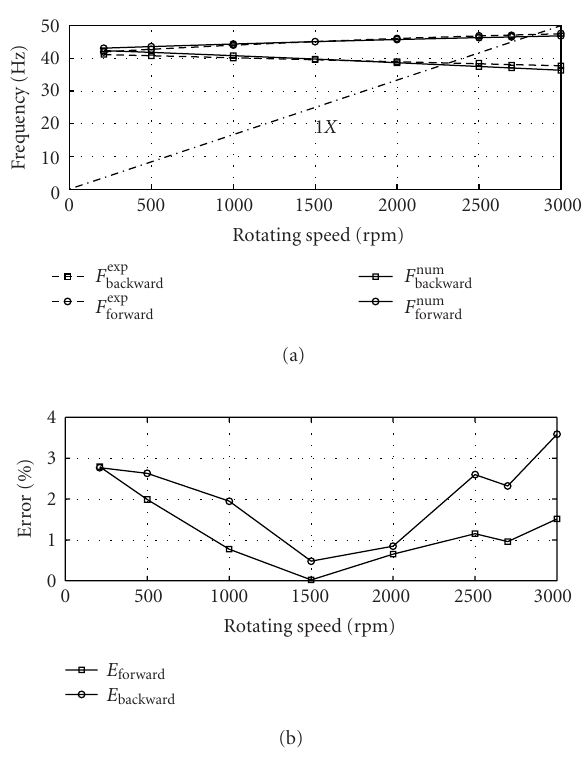
Figure 24: Minimization of the residue R for the configuration C